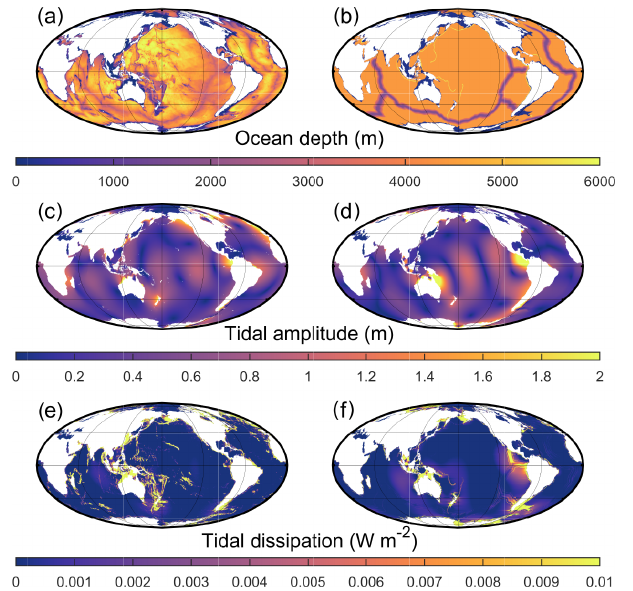
Figure 1. (a) The PD bathymetry in m. Panel (b) is the same as (a) but for the degenerate PD bathymetry (see text for details). (c– d) The simulated M 2 amplitudes (in m) for the control PD (c) and degenerate PD (d) bathymetries. Note that the colour scale saturates at 2m. Panels (e–f) are the same as (c) – (d) but show M2 dissipation rates in Wm − 2